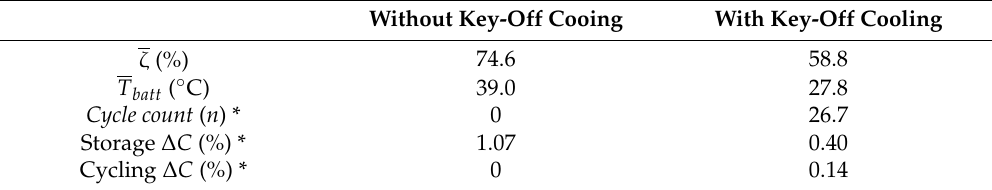
Table 6. Effect of applying key-off cooling as shown in Figure 8 on the battery. Data only represent Day Park. Without Key-Off